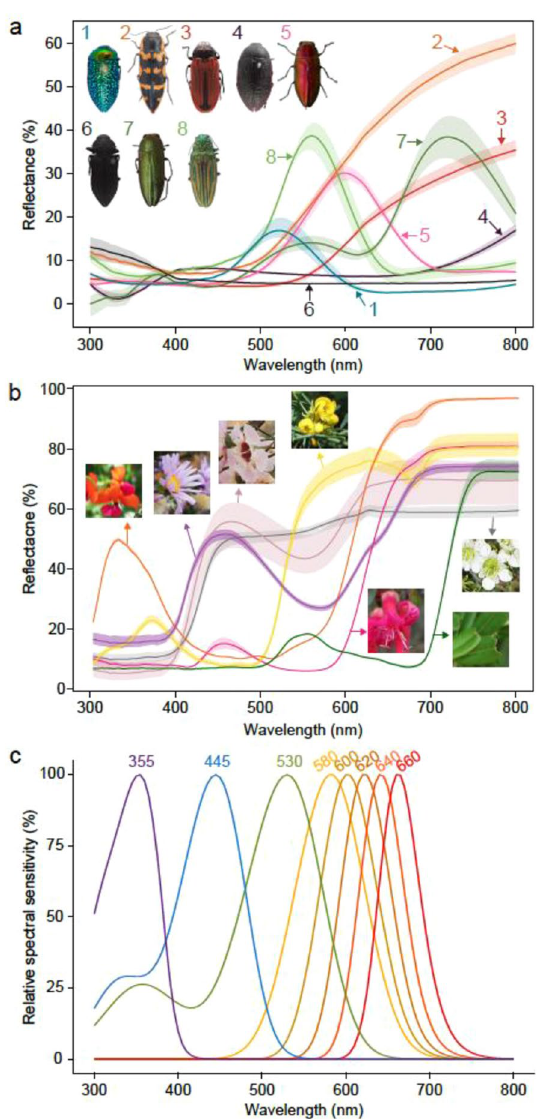
Figure 1. Spectral data used in visual modelling. ( a ) Reflectance spectra of representative beetle samples. Blue: Stigmodera gratiosa ; yellow: Cyria imperialis ; red: Castiarina erythroptera ; violet: Temognatha obscuripennis ; pink: Melobasis cuprifera ; black: Merimna atrata ; dark green: Melobasis propinqua ; green: Pseudotaenia gigas . ( b ) Reflectance spectra of representative leaf and flower samples. Orange: Chorizema cordatum ; purple: Olearia homolepis ; pink: Chamelaucium uncinatum ; yellow: Senna artemisioides ; red: Eremophila maculata ; white: Leptospermum liversidgei ; green: Gastrolobium bilobus . Shaded regions in ( a , b) show 95% confidence intervals of three replicates from the same species. ( c ) Sensitivity curves of photoreceptors with different peak wavelengths. ( a – c ) were created using R software version 3.6.3 (https:// www.r- proje ct. org) and modified using Inkscape version 1.0.2 (https:// inksc ape. org). Photographs by